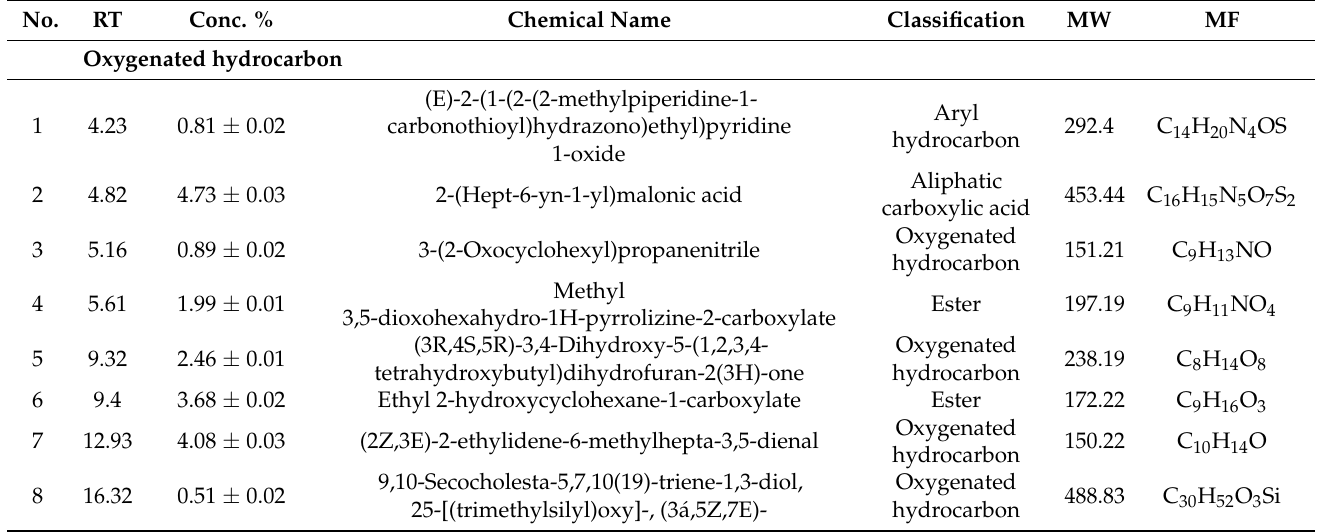
Table 1. Chemical characterization of the identified components in the aboveground parts of M. longipetala using GC-MS